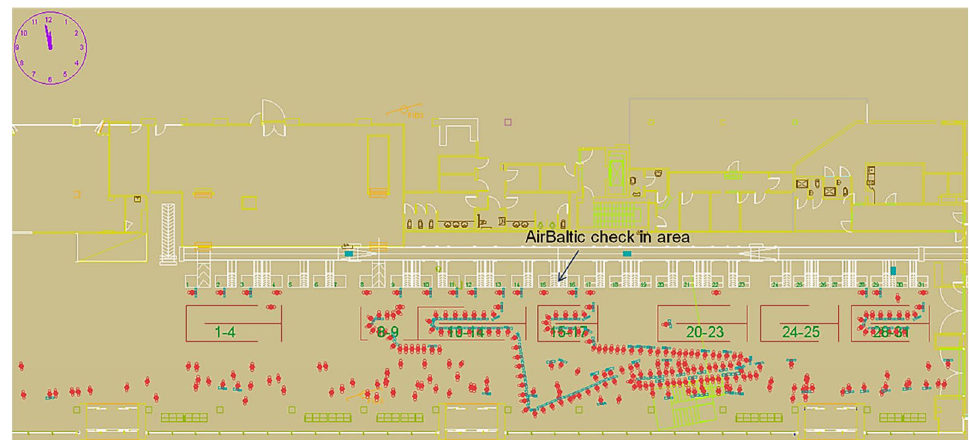
Figure 14. Visualisation of the check-in area for Scenario